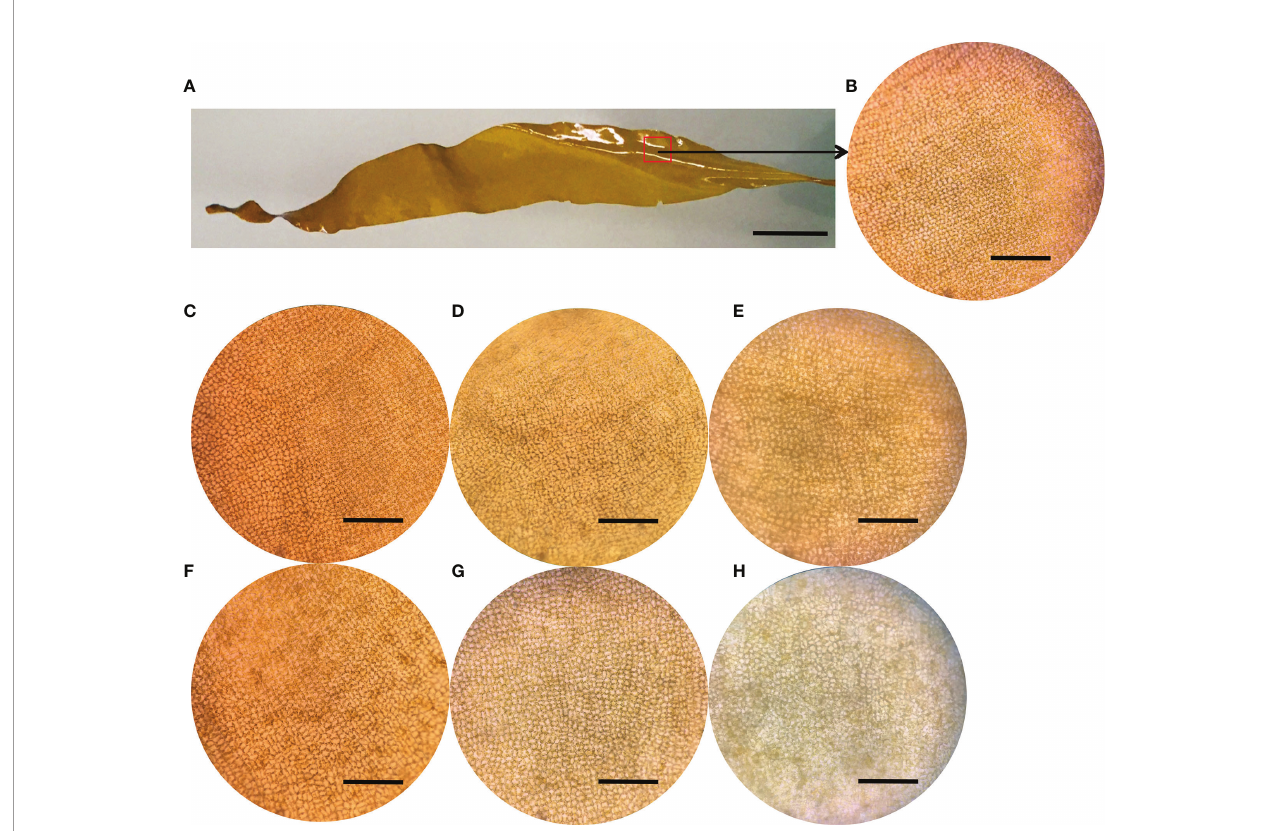
FIGURE 1 | The microscopic images of healthy juvenile sporophytes of S. japonica and the morphological images of tissue pieces in both control and PpX-8 infected groups. Control and infected tissue pieces were cultured under condition at 10 ± 1°C with the light intensity of 80 µE m 2 s – 1 and the photoperiod of 12 h: 12 h (L: D). (A) healthy juvenile sporophytes; (B) , tissue of healthy juvenile sporophytes; (C – E) control group at 4, 14 and 24 h, respectively; (F) infected group at 4 h; (G) infected group at 14 h with moderate bleaching symptom; (H) infected group at 24 h with high level of bleaching. Bars, a: 1.2 cm; b-h: 400 m m.